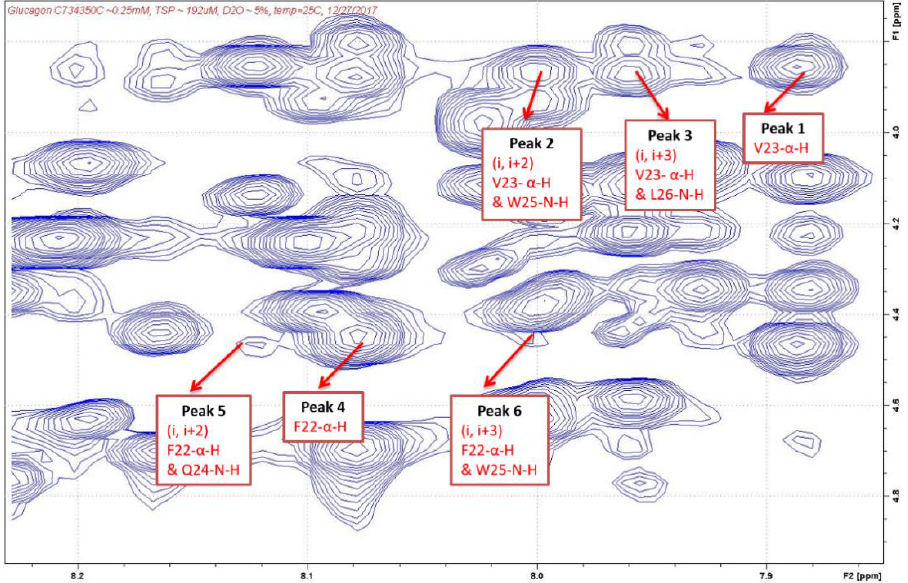
Figure 4. NOESY cross-peaks in